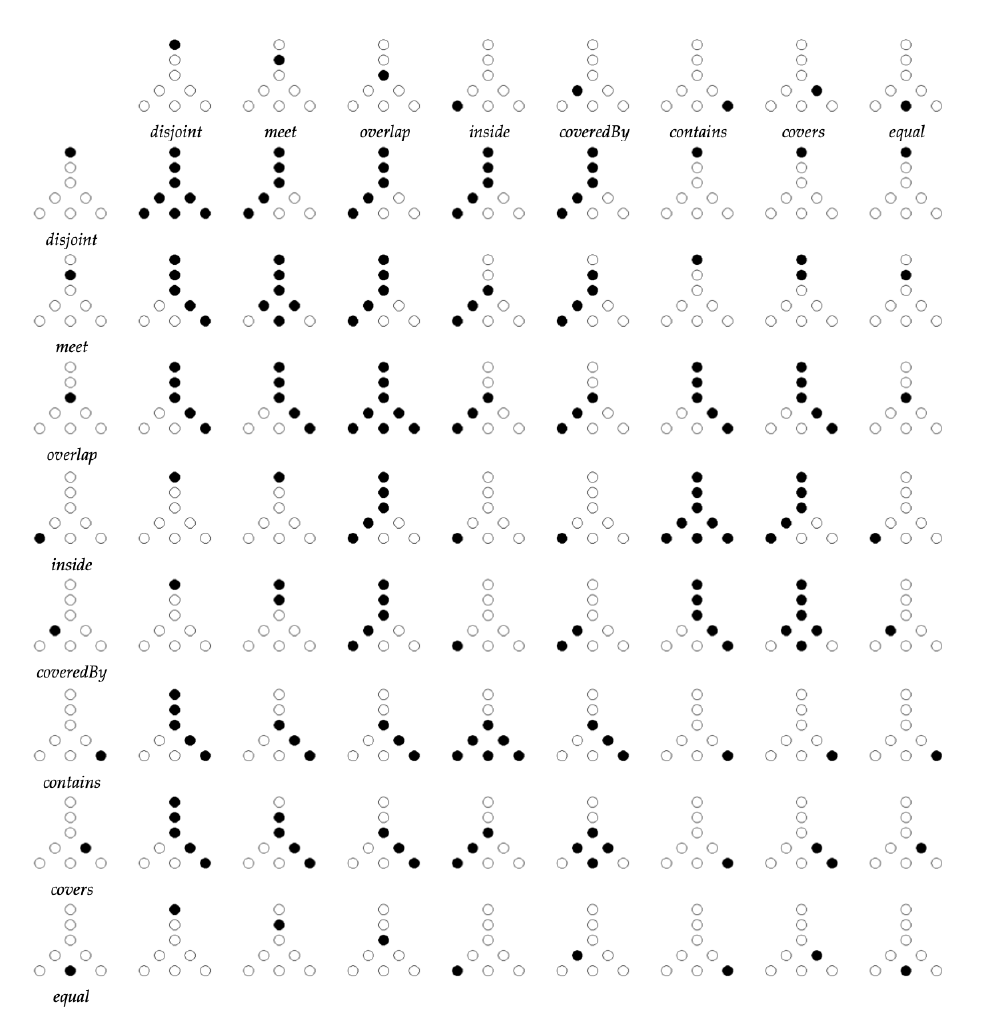
Figure 2: The composition table of the eight simple region-region relations